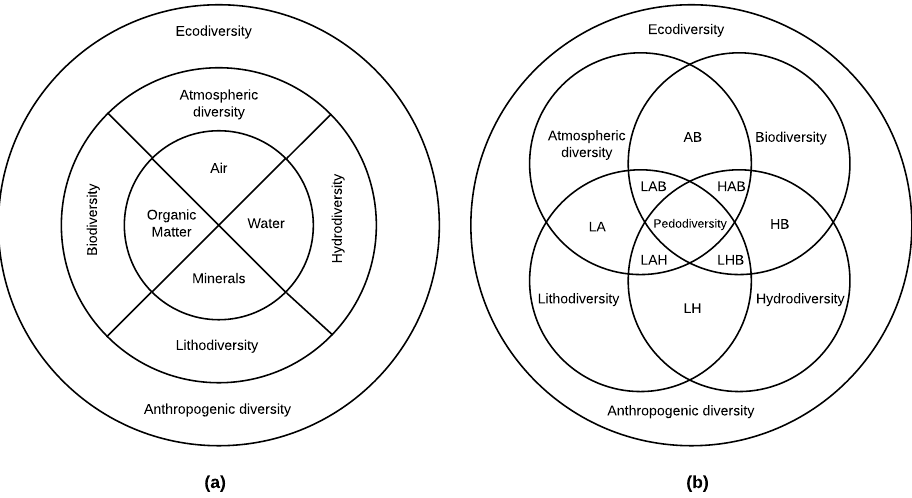
Figure 1. The scope of soil diversity (pedodiversity) (biotic + abiotic): ( a ) soil and relationship between soil components from the Earth’s various diverse spheres; ( b ) formation of two-sphere, three-sphere, and four-sphere (e.g., pedodiversity) systems in nature ( A = atmospheric diversity (abiotic + biotic); B = biodiversity (biotic); H = hydrodiversity (abiotic + biotic); L = lithodiversity (abiotic) (adapted from Mattson, 1938 [3]; Mikhailova et al., 2020 [12]; Ib á ñez et al., 1998 [13]). Pedodiver- sity is influenced by intrinsic (within soil itself) and extrinsic (environmental) factors (e.g., atmospheric